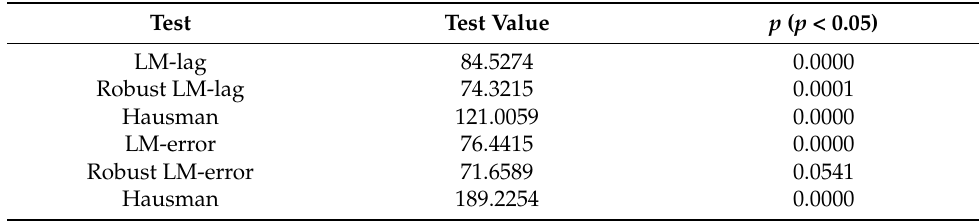
Table 5. The test of LM and Hausman and the P